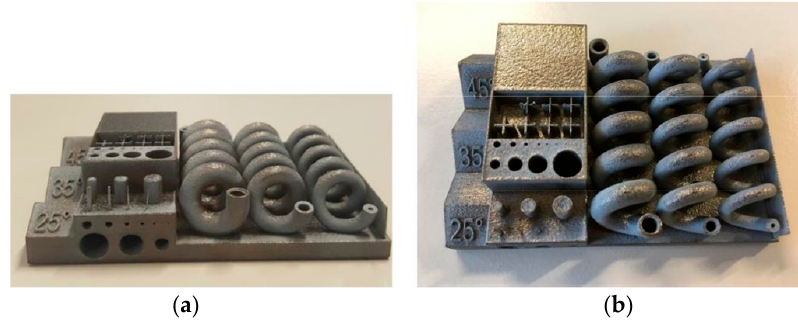
Figure 7. Views of samples received from company H. ( a ) front view, ( b ) top view.